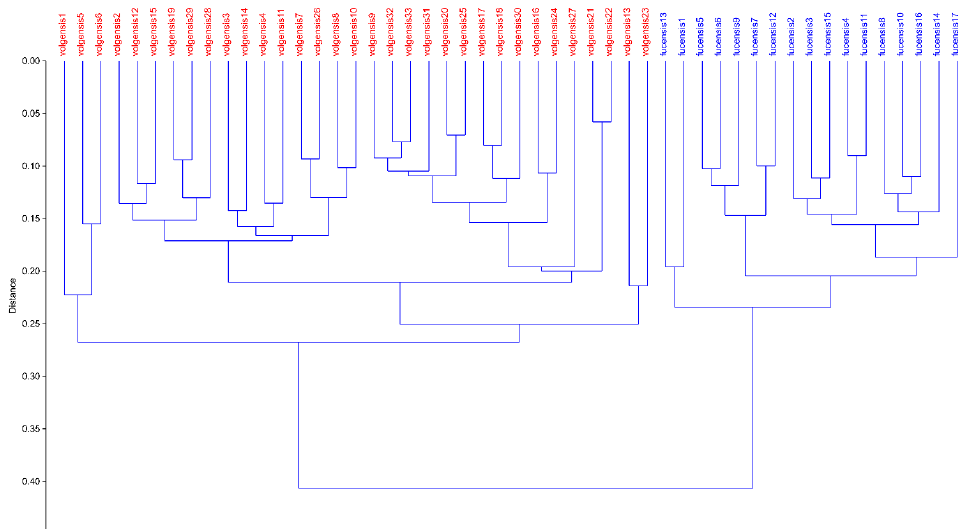
Figure 2. Hierarchical clustering of individuals of A. volgensis and A. fucensis using paired group algorithm (UPGMA) and Gower Similarity Index. Cophenetic correlation coefficient is 0.8566.